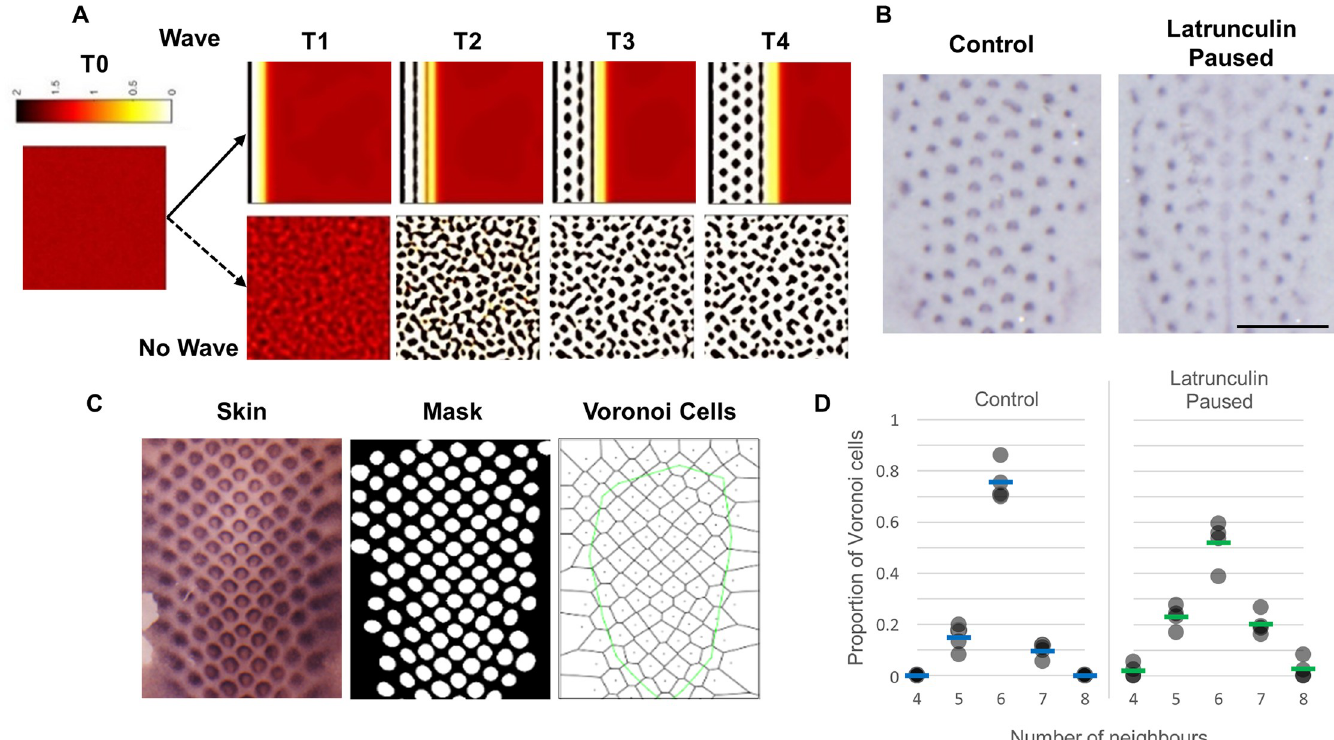
Fig 2. A travelling wave of primordium induction is required for high-fidelity pattern formation. (A) Time course output of a simulation of the patterning network shown in Fig 1J. A 2-dimensional patterning (bottom) yields an irregular array, whereas the same network deployed in a wave (top) yields a highly regular hexagonal pattern. (B) E6.5 skin explants cultured for a total period of 48 hours. Control explants display a hexagonal periodic pattern of high regularity. Explants treated for 24 hours with 150 ng/ml Latrunculin A to suppress feather primordium formation, followed by 24-hour incubation in normal medium to permit patterning, produces a pattern of low regularity. Scale bar: 1 mm. (C) Schematic of pattern fidelity analysis. CTNNB1 expression was detected and imaged, and a mask of the image was generated. Voronoi tessellation was constructed with primordium centroids as seeds. Boundary Voronoi cells were removed. (D) Plot of the distribution of shapes of Voronoi cells (i.e., number of first neighbours) in control and Latrunculin-paused skin patterns, as in panel B. The proportion of each n -sided shape for each skin sample is shown as a single data point. The numerical values for D can be found in S2 Data. E, embryonic day.